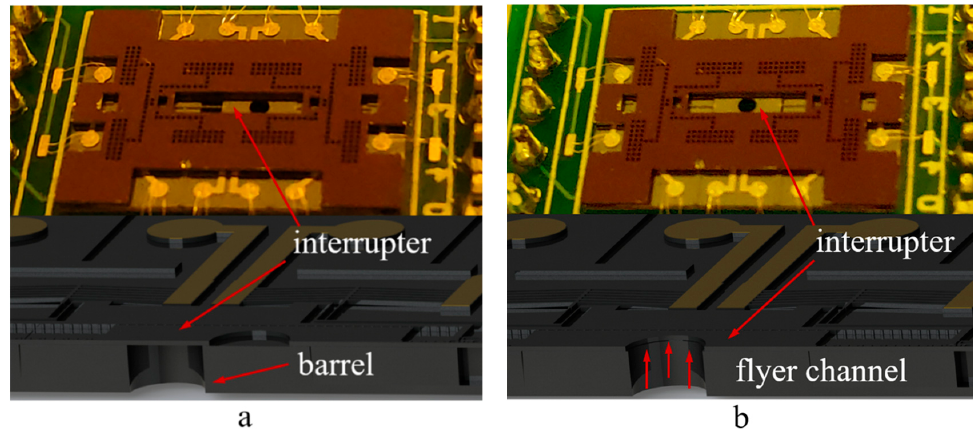
Figure 2. The conversion of the S&A (safety and arming) chip between safe status and arm status: ( a ) Safe status; and, ( b ) Arm